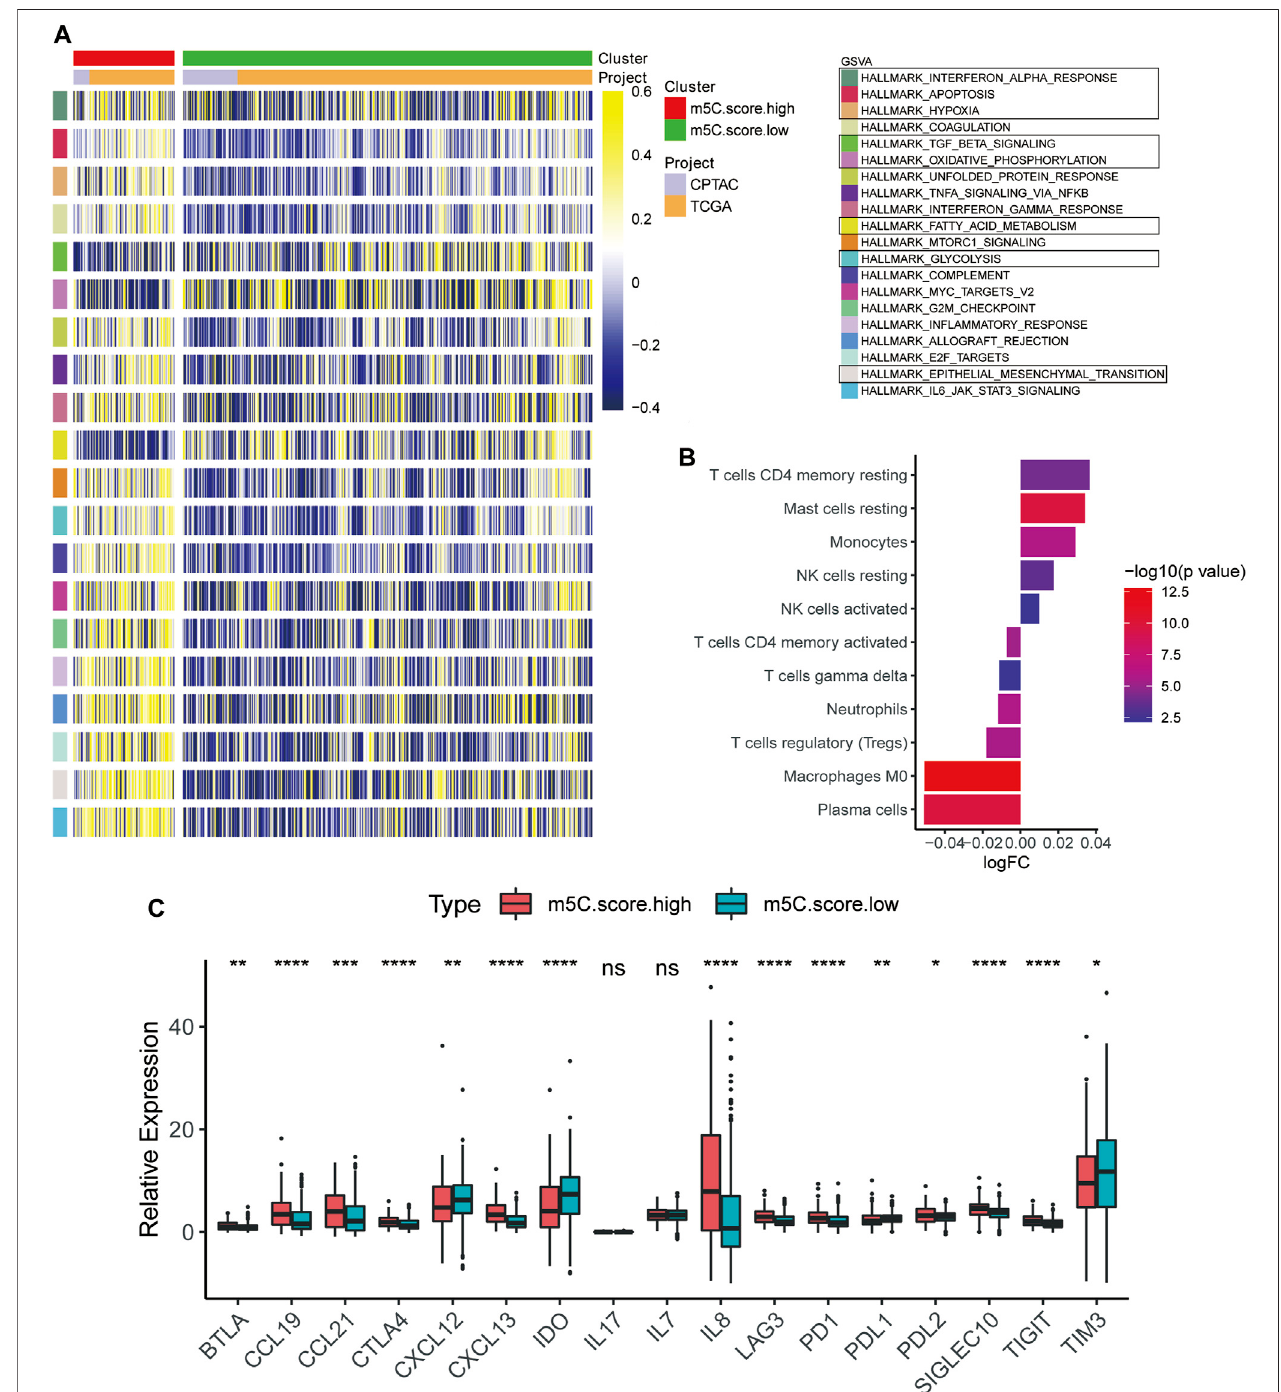
FIGURE 8 | Characteristics of TME and immune cell distribution in m 5 C-related phenotypes. (A) GSVA results of high and low m 5 C score groups based on expression pro fi les from CPTAC and TCGA cohorts. (B) Estimation of immune cell in fi ltration in high and low m 5 C score groups. (C) Expression levels of chemokines, cytokines, and immune checkpoints between high and low m 5 C score groups.